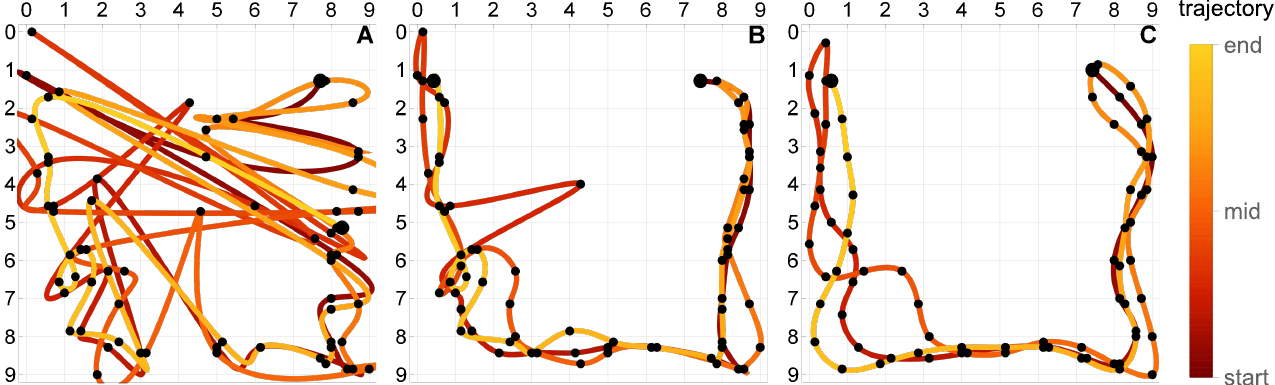
Figure 15. Identification of the compound U trajectory shown in Figure 12b. The trajectories A, B and C correspond to the three points marked on the respective Pareto front in Figure